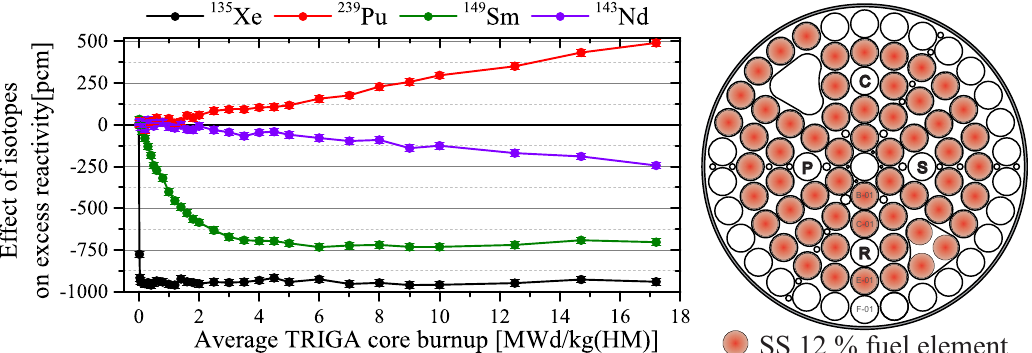
written showing the quality of fit.